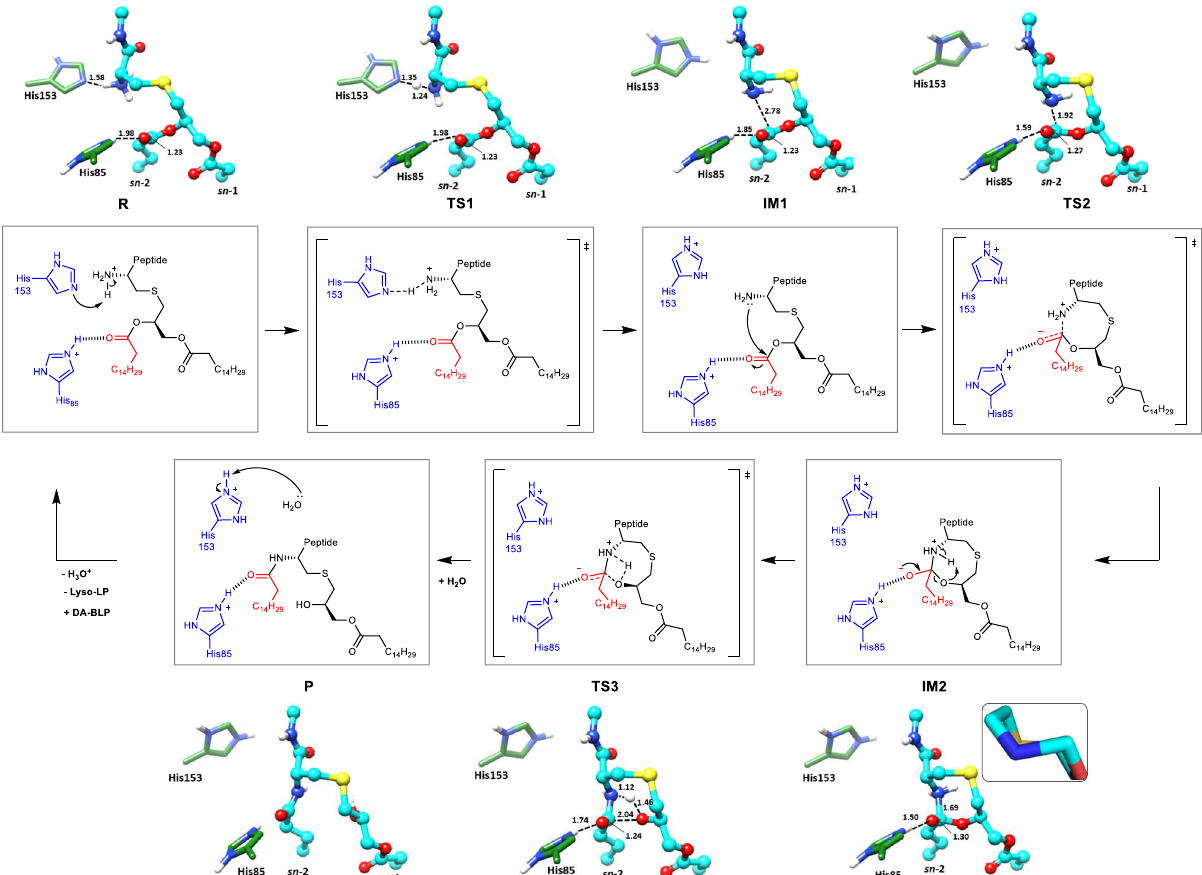
Fig. 4 Proposed mechanism of the Lit intramolecular transacylation reaction. (Inner panels). The general acid – base mechanism invokes His153 as the nucleophile which abstracts a proton from the free α -ammonium group of cysteine in the DA-BLP substrate. The newly formed amine (intermediate 1, IM1), attacks the carbonyl carbon at the sn -2 position of the DAG forming an eight-membered heterocyclic intermediate with tetrahedral carbon and nitrogen atoms (intermediate 2, IM2). The negative charge on the oxygen bonded to the tetrahedral carbon is stabilised by the proximal His85 which remains protonated throughout the reaction. Collapse of the intermediate gives rise to the lyso-BLP product (P). Deprotonation of His153 by equilibration with bulk water restores the enzyme to its original form in preparation for another round of reaction. Transition state structures (TS1, TS2 and TS3) are shown in square brackets. TS3 includes a transient four-membered ring containing carbon, nitrogen, hydrogen and oxygen atoms that is stabilised presumably by local bonded and non-bonded interactions. (Outer panels) 3D structures of complexes between Lit and reactant, transition states, intermediates and product derived from QM/MM. The eight-membered heterocyclic intermediate (IM2) adopts a chair-like conformation (inset), which was maintained throughout the MD simulations. The acylated cysteine is shown with cyan carbon atoms. The catalytic histidines have green carbons. Polar and hydrogen bond interactions are shown as dashed lines with distances in ångströms. Dashed lines in the transition states represent forming and breaking partial bonds. The bond between the carbon and the non-bridging oxygen in the sn -2 acyl chain is identi fi ed by a black